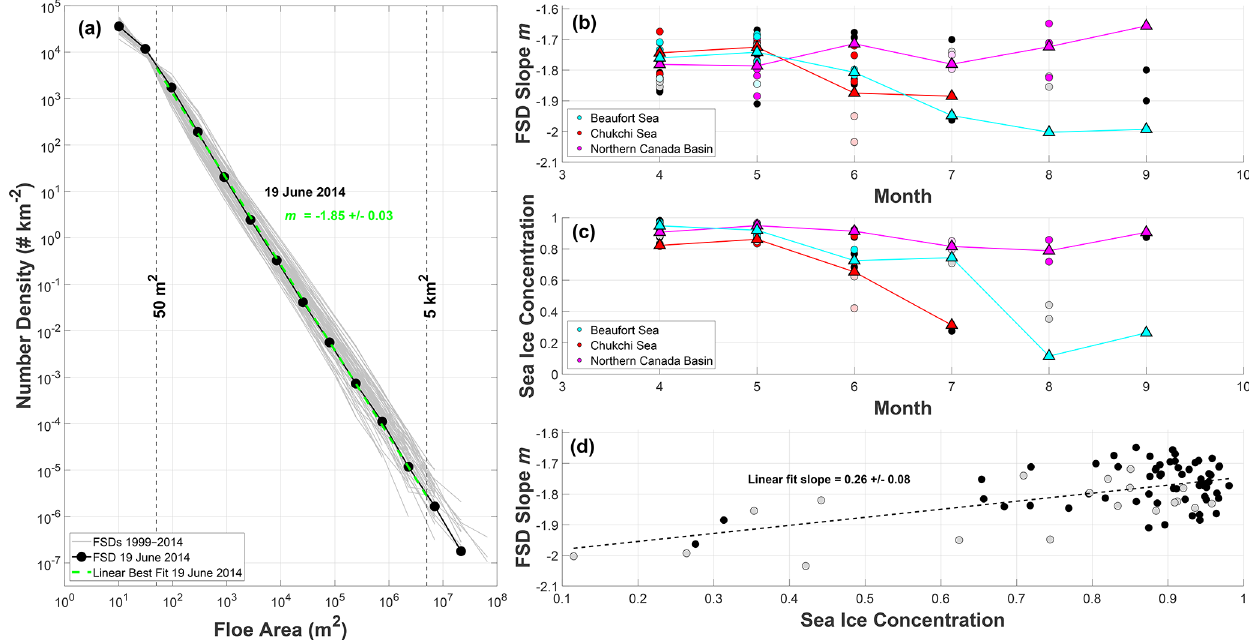
Figure 3. FSDs and FSD slopes m versus month, SIC (fractional area) versus month, and slopes m versus SIC, for 78 satellite images acquired from 1999 to 2014 in April through September of those years. (a) FSDs (gray lines) are plotted on a log-log scale using 15 logarithmically spaced bins for the range of floe areas spanning 5m 2 to 100km 2 and the requirement of a bin count of at least 2 floes. A representative FSD is shown for the 19 June 2014 image (black line with solid circles) with a linear best-fit (green dashed line) and slope m (green). Fits are taken from 50m 2 to 5km 2 for reasons discussed in Sects. 2.2.3 and 2.3. (b) FSD slopes m versus month. In (b) – (d) , black dots are shown for images segmented with high confidence and gray dots for those segmented with low confidence. Slopes m for the three GFL site (see Fig. 1a) images only are shown in cyan (Beaufort Sea), red (Chukchi Sea), and magenta (northern Canada Basin), with mean monthly slopes (triangles). (c) SIC versus month. SICs for the GFL site images only are shown again in cyan (Beaufort Sea), red (Chukchi Sea), and magenta (northern Canada Basin), with mean monthly SICs (triangles). In (b) and (c) , individual slopes and SICs from low-confidence segmentations at the GFL sites are shown in a lighter shade of each site’s designated fill-color. (d) FSD slopes m versus SIC and linear fit (black dashed line) with slope (and 95% confidence